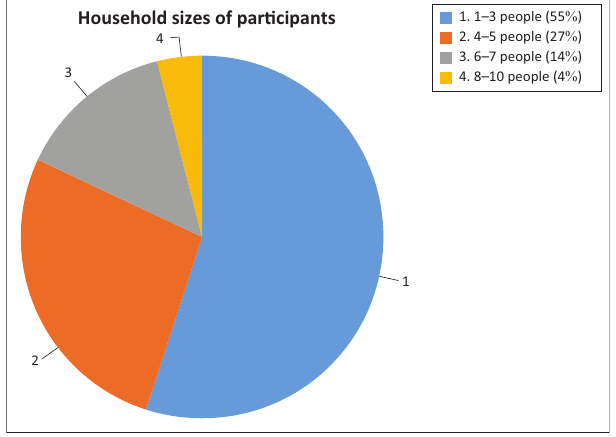
FIGURE 2: Age distribution of participants.